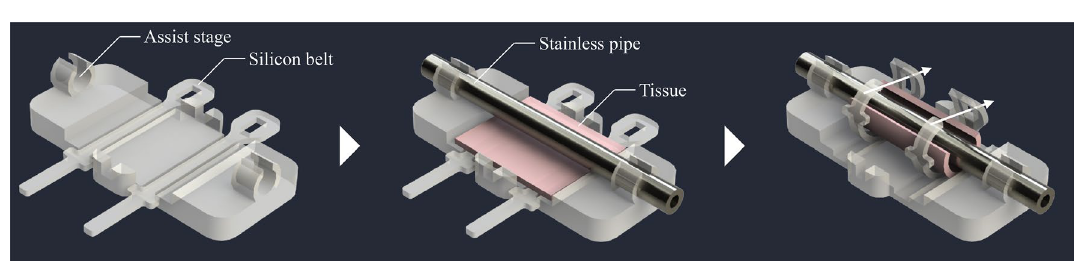
Figure 15. An auxiliary device for aseptic and reproducible tissue wrapping on glass fiber. A part of the image was created by the rendering function of SOLIDWORKS